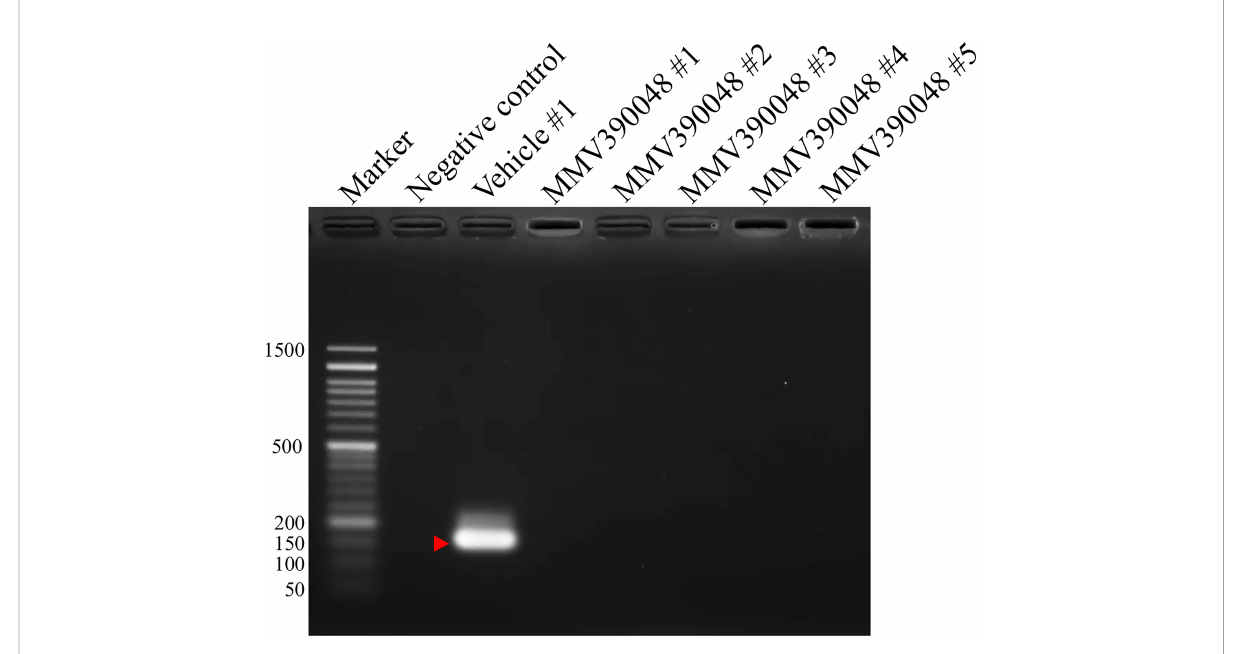
FIGURE 2 Molecular detection of parasite DNA in the blood of MMV390048-treated group (#1-5) at 92 DPI. The red arrow shows the expected band length of 154 bp for the B. microti 18S-rRNA